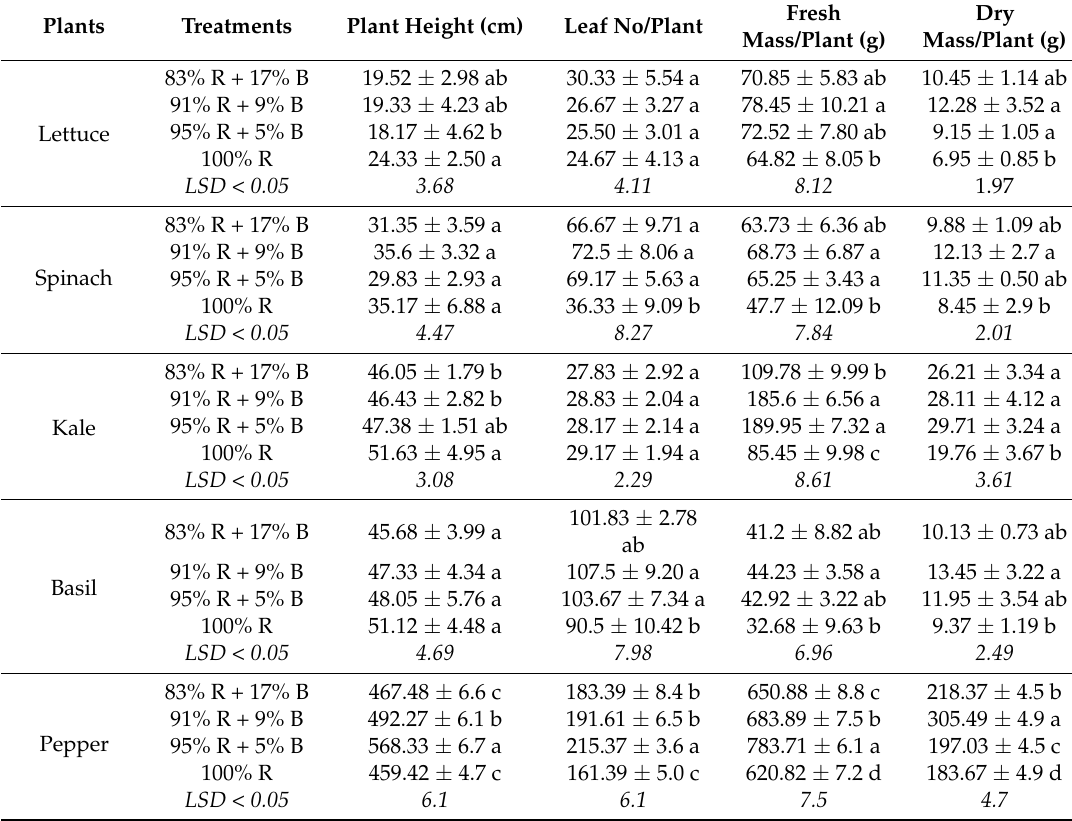
Table 1. Plant response of selected vegetable crops to a different percentage of R and B LEDs. Plants Treatments Plant Height (cm) Leaf No/Plant